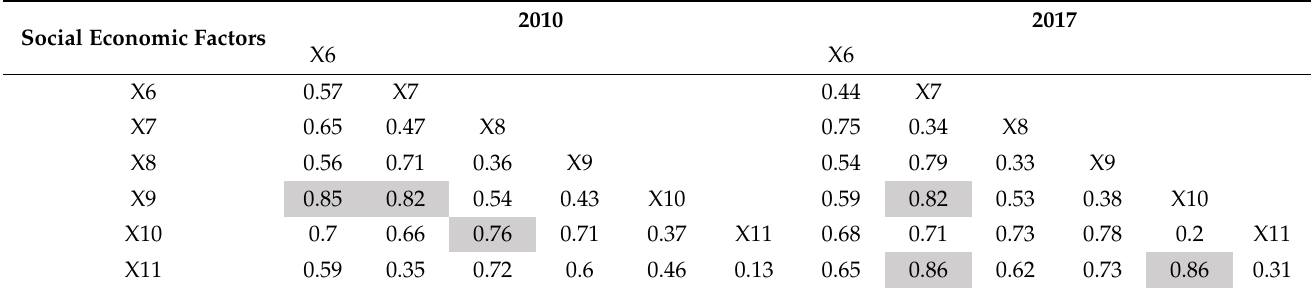
Table 6. Interaction effects of the Social economic factors on PM 2.5Cement . The gray shaded items are the top three values in the two years. X6–11 are the Social economic factors found in Table 1. Social Economic